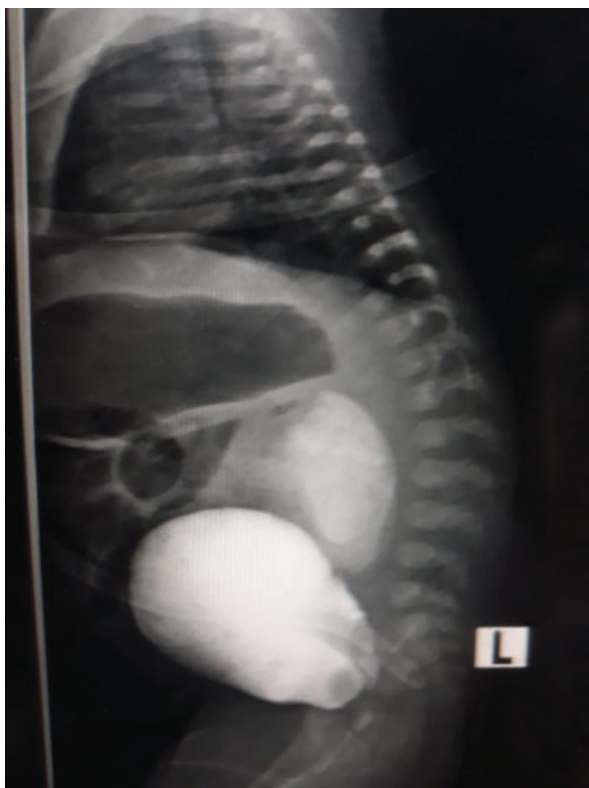
Fig. 2 Ascending cytogram (lateral view) showing an intraperitoneal leakage of contrast from the dome of the bladder posteriorly close to the